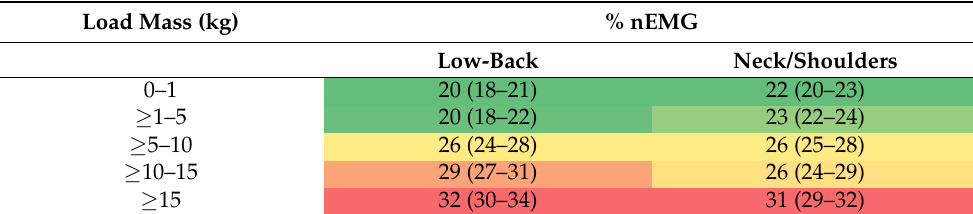
Table 2. Muscular workload by load mass. Estimates are presented as % nEMG (95% CI). Load Mass (kg) % nEMG Low-Back